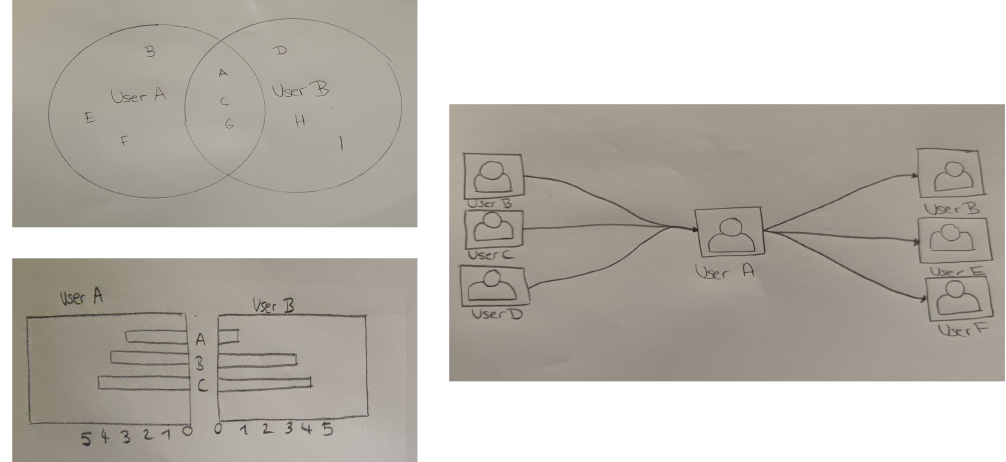
Figure 9. Socialize : Visualizing users with similar interests and influencing/influenced